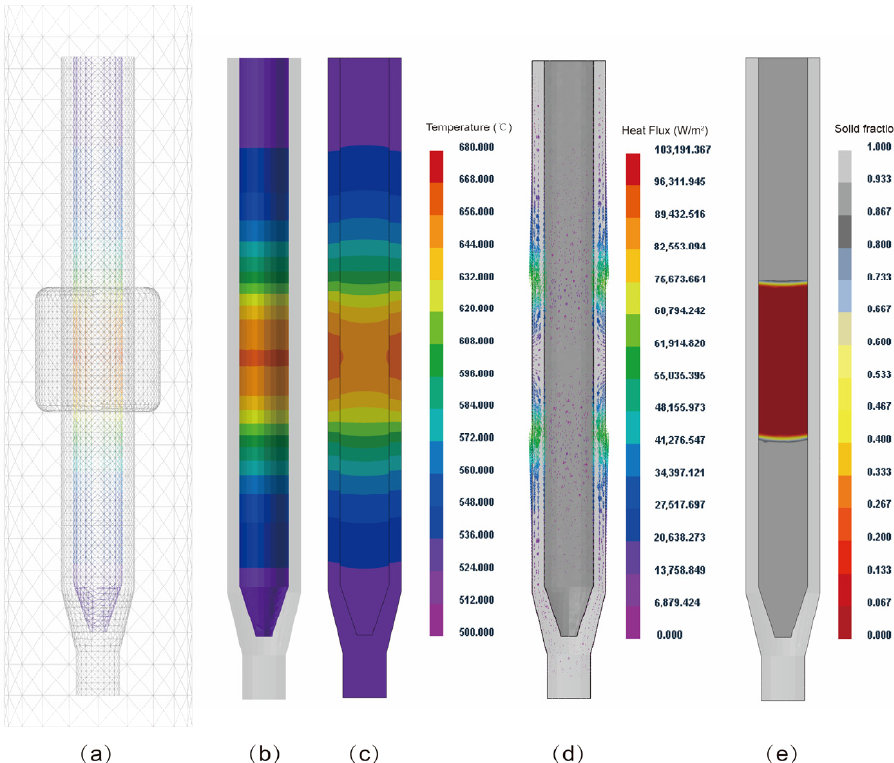
Figure 4. Heat flow and temperature analysis during zone melting process of bismuth telluride- based crystal material. ( a ) Simulation grid, ( b ) surface temperature distribution, ( c ) cross section temperature distribution, ( d ) heat flow analysis, ( e ) melting zone analysis.